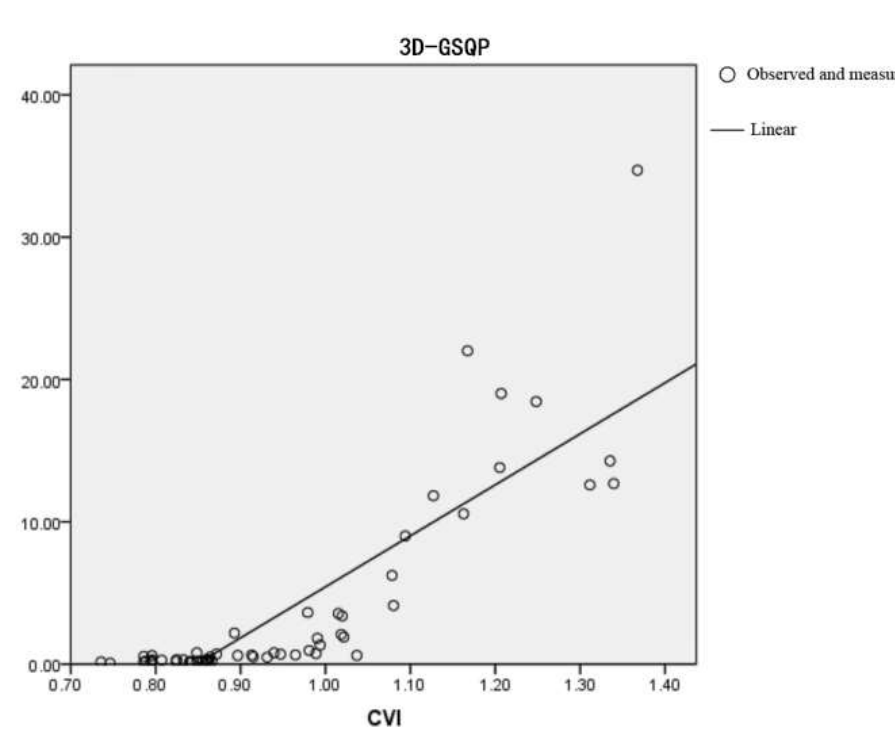
Figure 5. The results of linear regression simulation with chlorophyll vegetation index (CVI) and three-dimensional green space quantity per unit area (3D-GSQP) (m 3 /m 2 ).